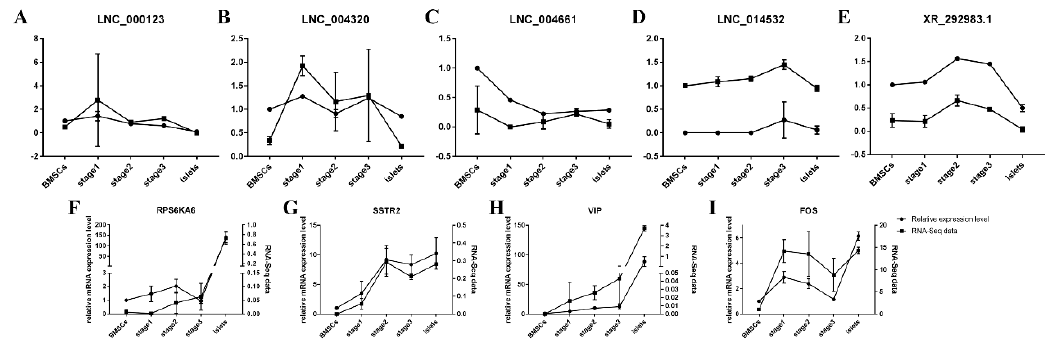
Figure 8. Validation of five differentially expressed lncRNAs ( A – E ) and four relative genes ( F – I ).